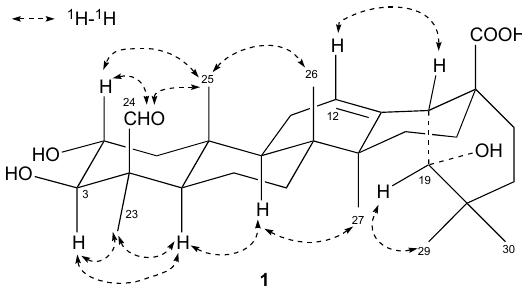
Figure 3. Selected NOESY correlations of compound 1 .